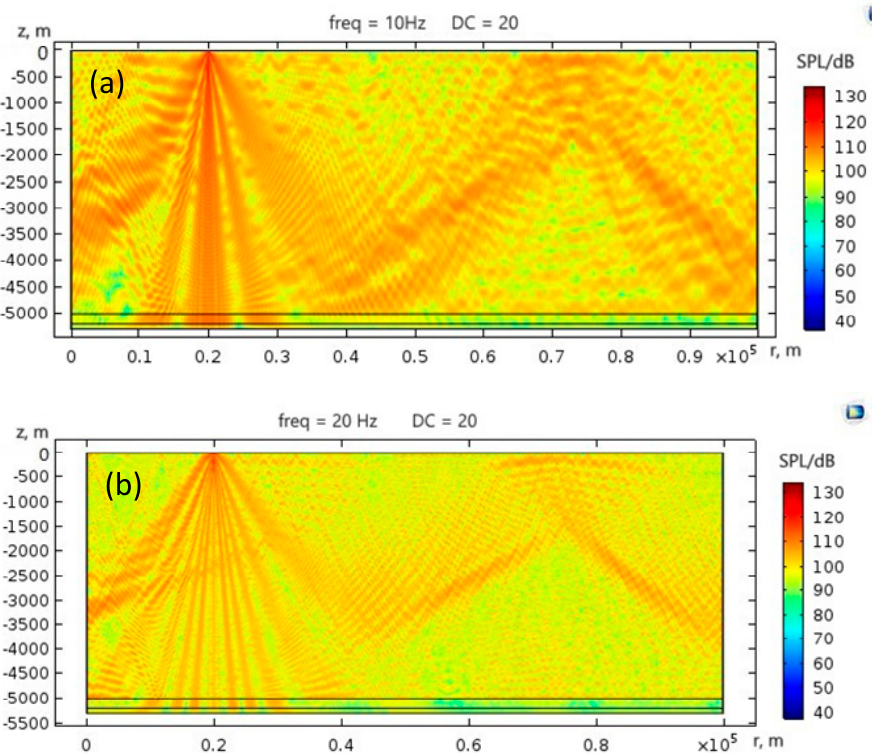
Figure 16. Sound pressure level distribution image at different frequencies when DC = 20 m/s, ( a ) f = 20 Hz, ( b ) f = 10 Hz.